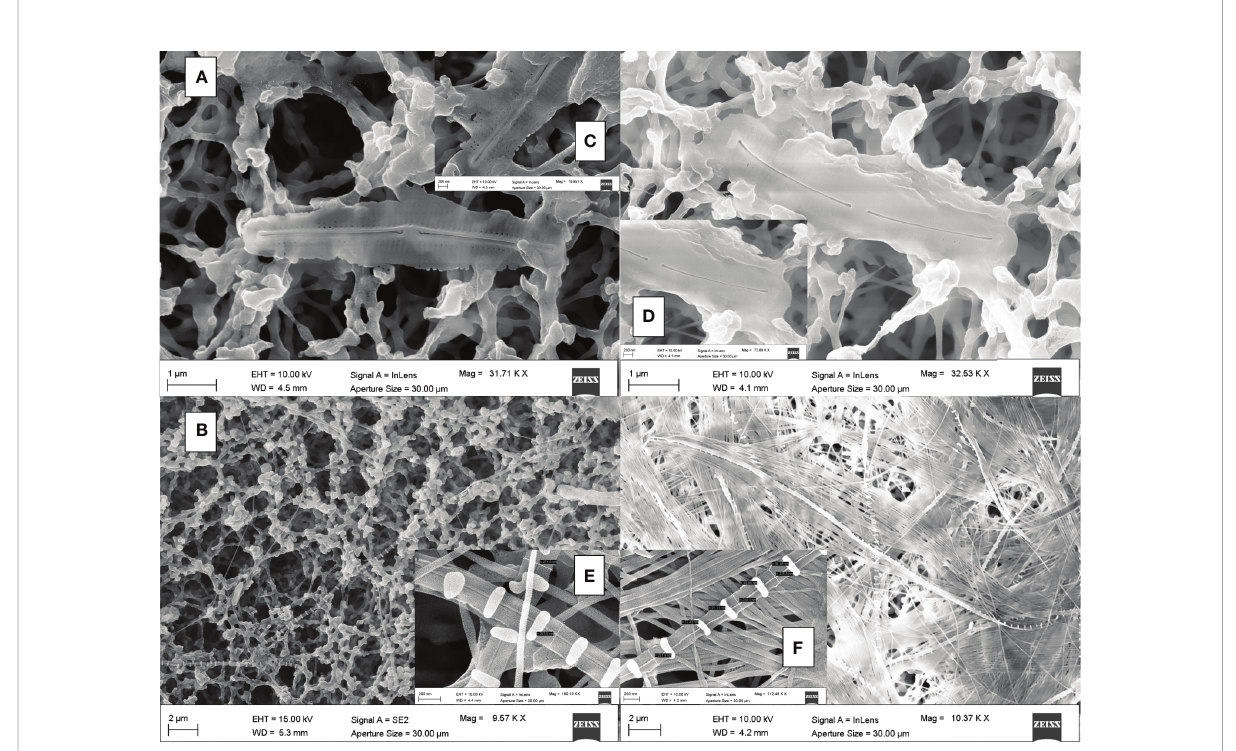
FIGURE 5 SEM images of frustules from P. tricornutum (A) and C. fusiformis (B) acclimated to 500 µM Si (left images) and 25 µM Si (right images). Details of P. tricornutum and C. fusiformis raphe at 500 µM Si ( (C, E) respectively) and 25 µM Si ( (D, F) respectively) are